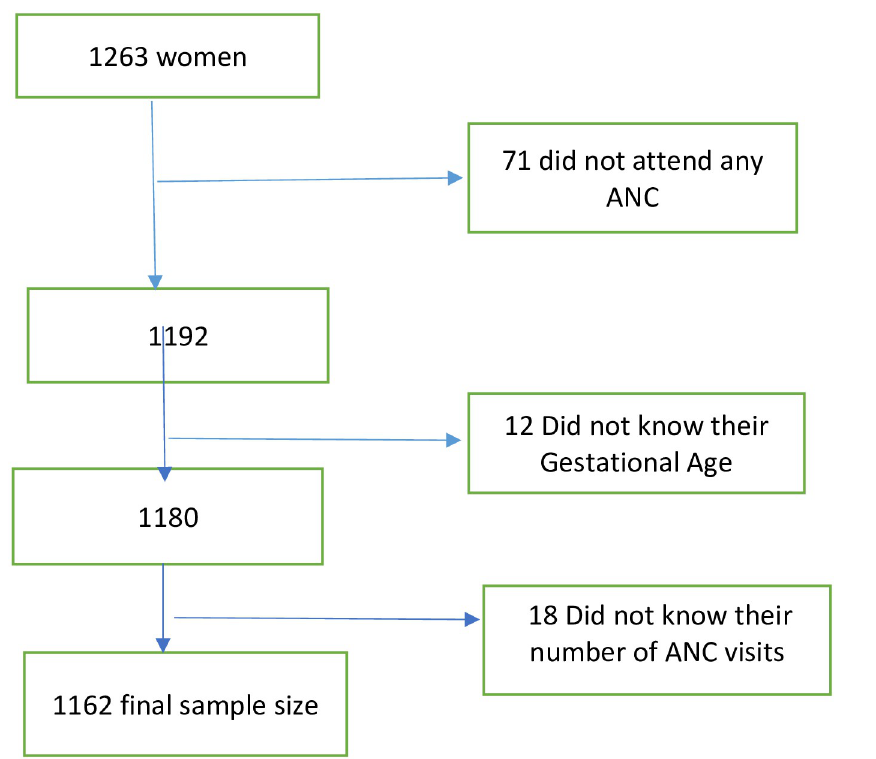
Fig 1. Flow chart showing enrolment of